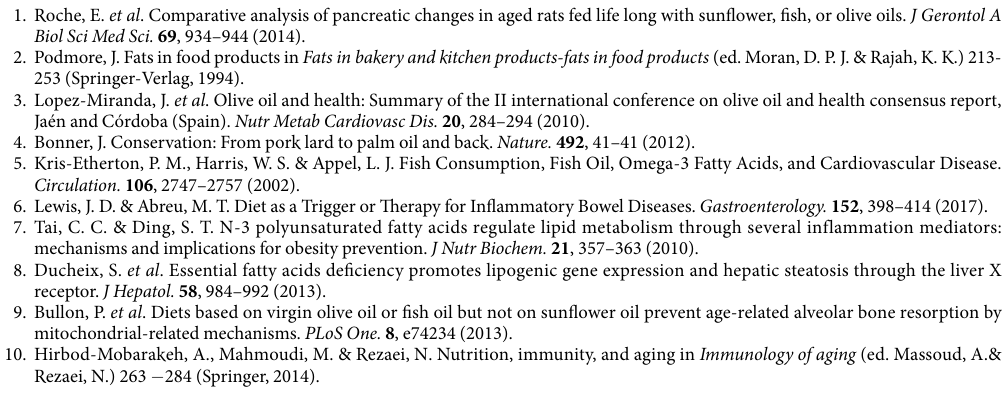
Supplementary Table S5. The aTL was calculated as follows: = aTL amount of telomere sequence per reaction(kb)/genome copy number (2) Statistical